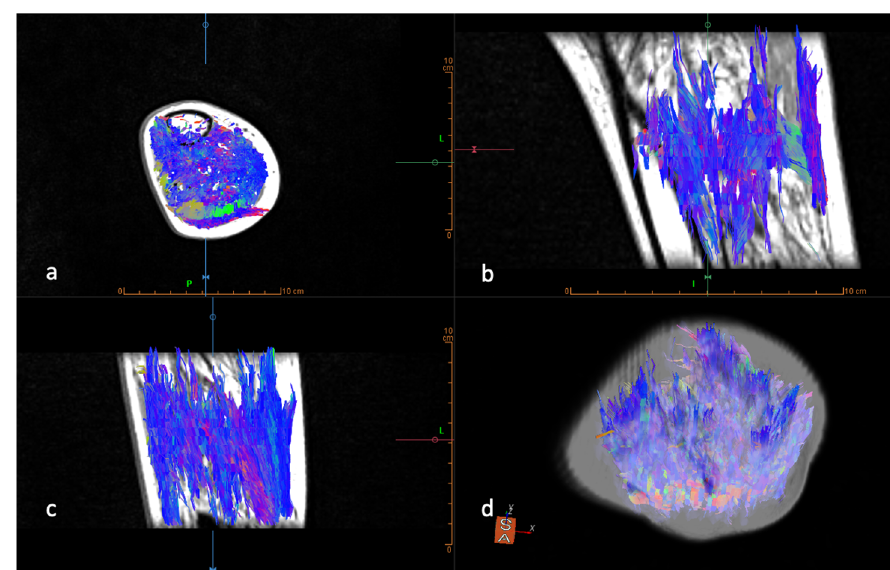
Figure 4. Axial ( a ), sagittal ( b ), coronal ( c ), and axial fusion tractography ( d ) images of a type II spinal muscular atrophy patient show rarefaction of regular muscle fibers. The DTI sequence (slice thickness: 3 mm, b value: 400, number of directions: 12) shows a mean FA value of 0.61 calculated on leg muscle compartments ROI.